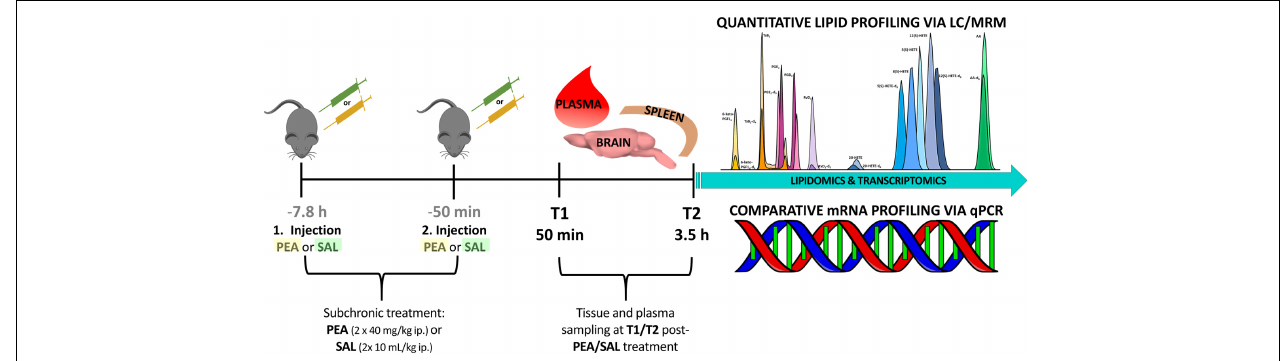
FIGURE 1 | Experimental timeline of PEA/Sal treatment: in total 24 mice were ip injected either with saline ( n = 12) or with a dose of 40 mg/kg PEA ( n = 12) each in a total volume of 10 mL/kg (1 st injection, at 7.8 h prior to sacrificing) . After 7 h the same procedure was repeated (2 nd injection, at 50 min prior to sacrificing) . At time point 1 (50 min post – 2 nd injection) 12 mice were sacrificed and plasma, brain, and spleen samples from PEA-treated ( n = 6) and saline-treated ( n = 6) mice were collected for further analysis. This procedure was repeated with remaining 12 mice, e.g., PEA-treated ( n = 6) and saline-treated ( n = 6) mice, at time point 2 (3.5 h post – 2 nd